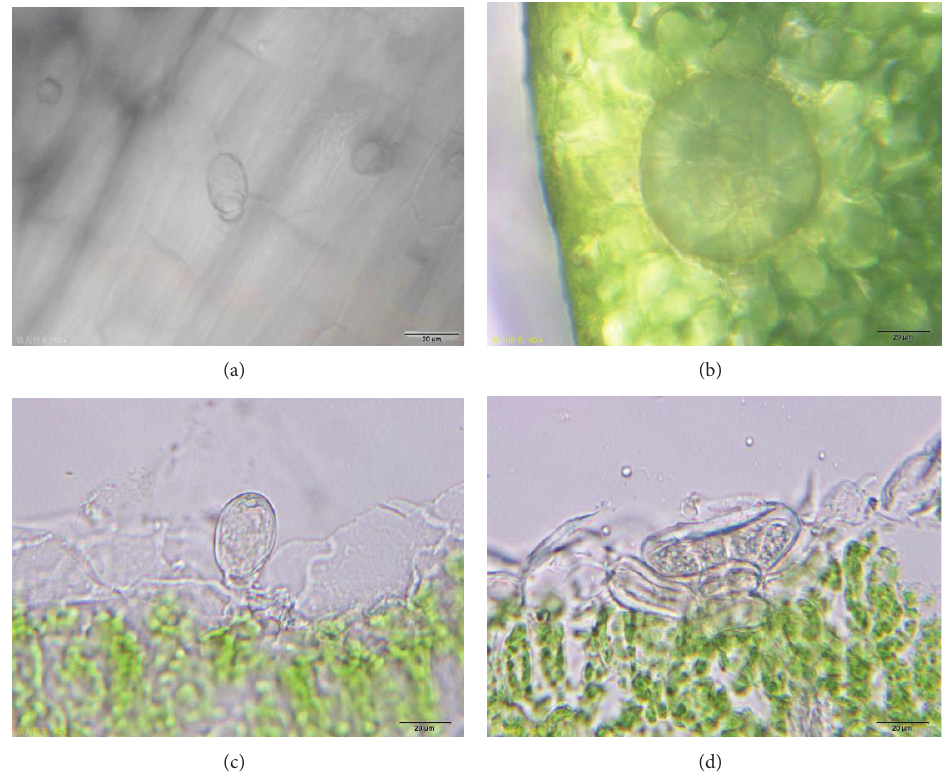
Figure1:(a)-(b)Surfaceviewofamatureleafof T. quinquecostatus .(a)Acapitatetrichome.(b)Apeltatetrichome.(c)-(d)Transversesections of a mature leaf of T. quinquecostatus . (c) Structure of a capitate trichome structure. (d) Structure of a peltate